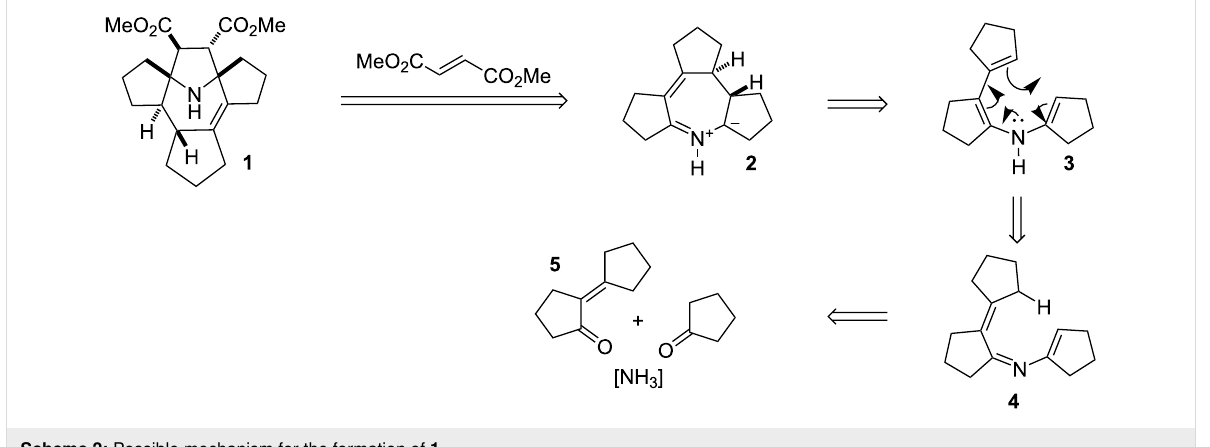
Scheme 2: Possible mechanism for the formation of 1 .